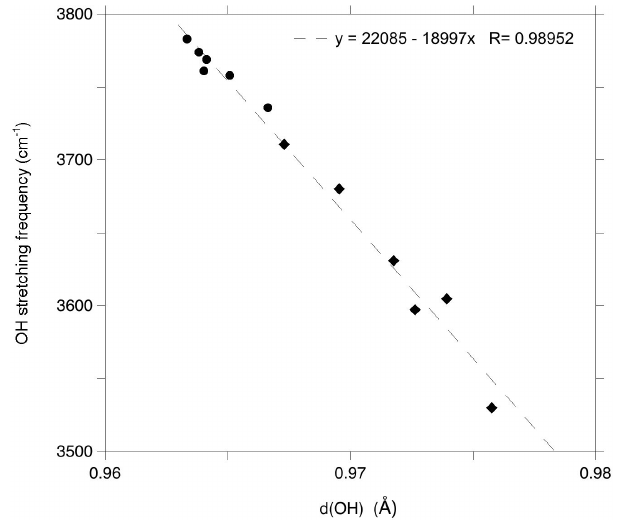
Figure 6. Relation between the theoretical stretching frequency (Ta- ble 2) and length (Table 1) of OH bonds in the lizardite models. For stretching modes displaying coupled OH contributions, the average values have been considered. Circles: inner-OH groups; diamonds: interlayer-OH